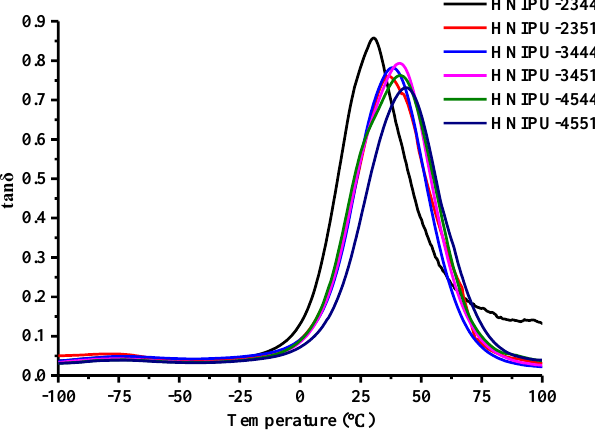
Figure 6. tan δ as a function of temperature for different Figure 6. tanδ as a function of temperature for different HNIPUs. Figure 6. tanδ as a function of temperature for different HNIPUs.